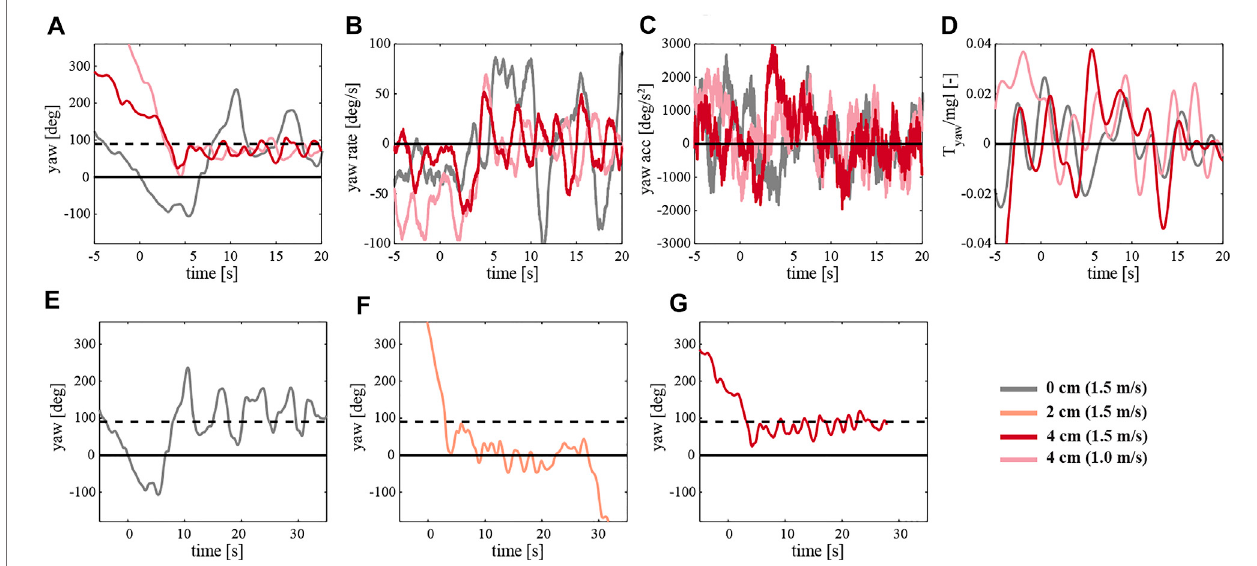
FIGURE14| Theaverageyawtorquesanddihedralanglesgatheredduring5 sof fl ightexperimentswiththerobot fl yingwithoutyawcontrolinaside-wind.The5 s time window correspond to the moment that the robot transitioned from sideways fl ight to forward fl ight in the wind gust. (A,B) Yaw torques (A) and dihedral angles (B) as a function of sideways velocity for the robot fl ying with a mass displacement of 0 cm, 2 and 4 cm (in grey, orange and red, respectively). (C) Yaw torques versus dihedral angle for the same cases as shown in (A,B) . The solid black line shows a linear fi t through all data combined.